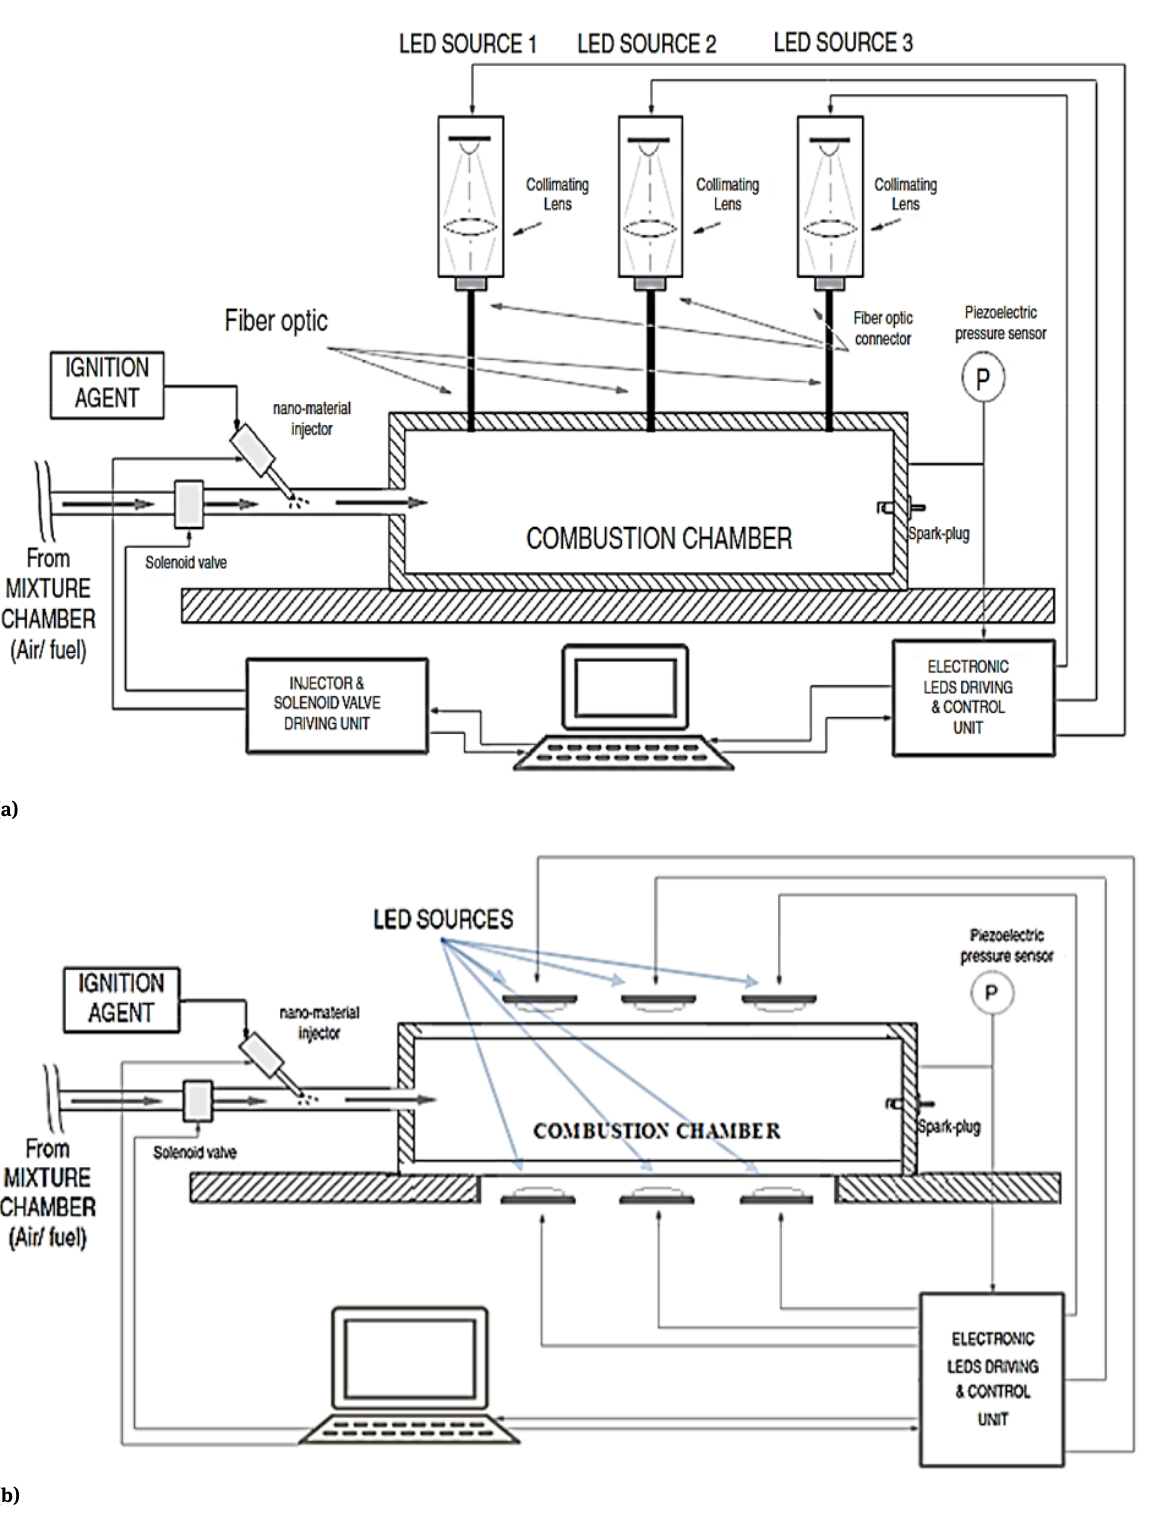
Figure 11: Experimental setup used to carry out the combustion tests on different air-fuel mixtures that employs optical fibers to convey the light emitted by LED sources into the combustion chamber (or into the cylinder as reported in Figure 10 related to the use of lasers) (a); view of a similar experimental setup where LEDs sources are directly coupled with combustion chamber by quartz